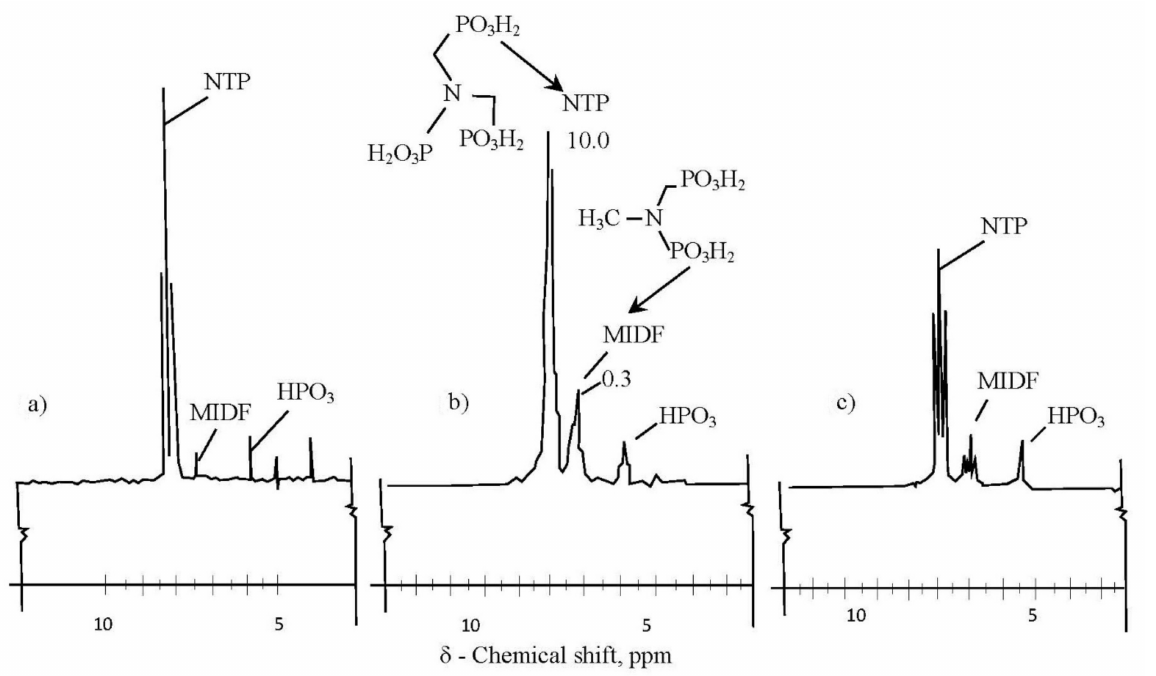
Figure 19. Spectrums of nuclear magnetic resonance investigations. The resonant adsorption frequen- cies versus chemical shift, ( a ) Jurby-Soft; ( b ) Aminat-K; ( c ) Actoscale. Table 3. Ratios of concentrations of the main components in phosphonicacid-based antiscalants.